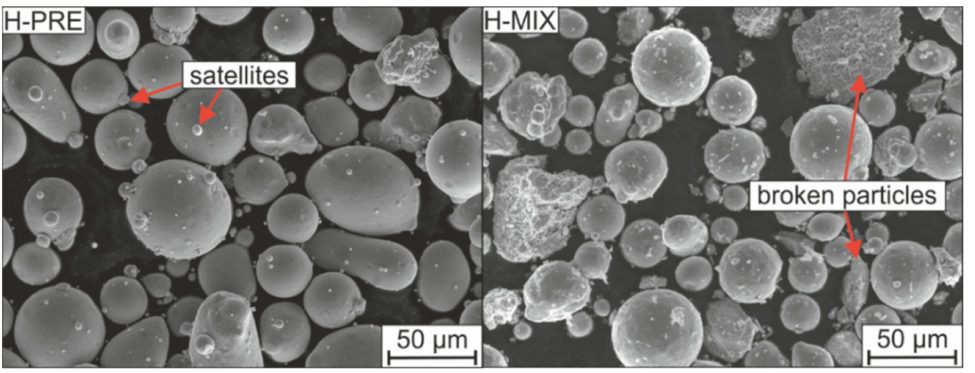
Figure 1. H-PRE and H-MIX powder